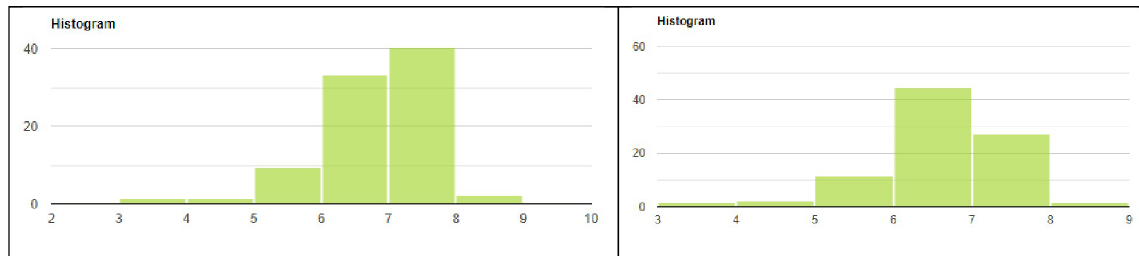
Fig 1. Histogram of normalized Google Analytics and SimilarWeb visits data. Effect sizes Are Very Small and Small Respectively, Indicating the Difference Between the Sample Distribution and the Normal Distribution is Very Small/Small.